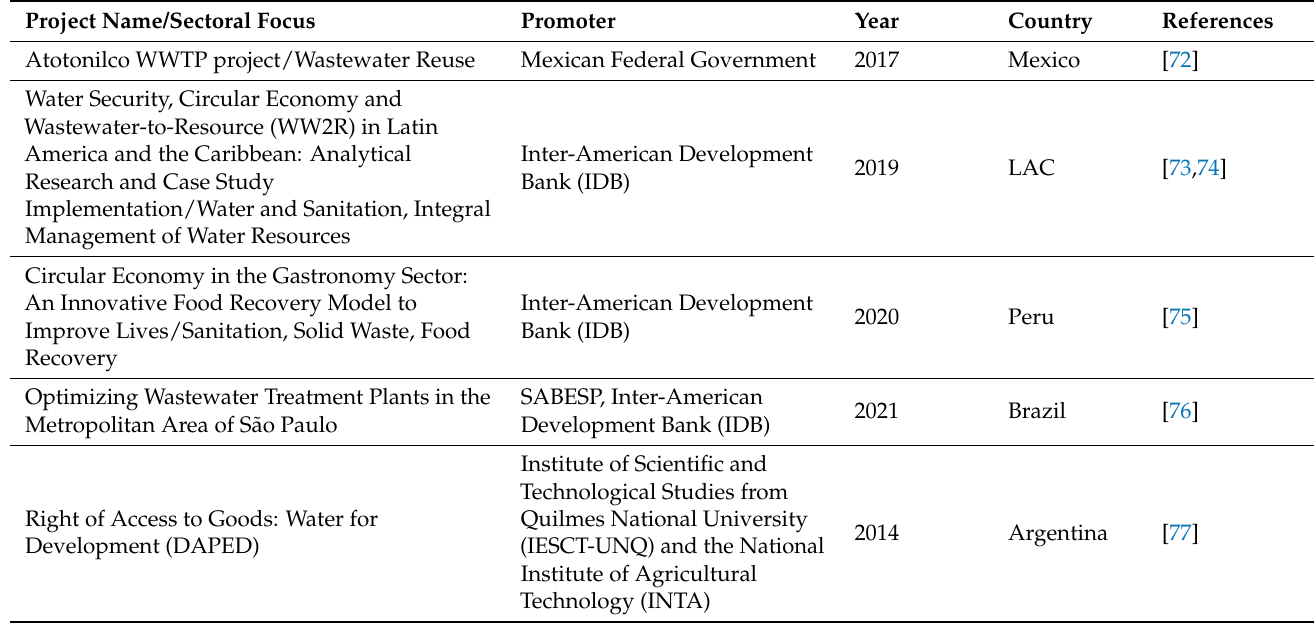
Table 2. Overview of Circular Economy projects and programs in the LAR focusing on the water sector and the scale of